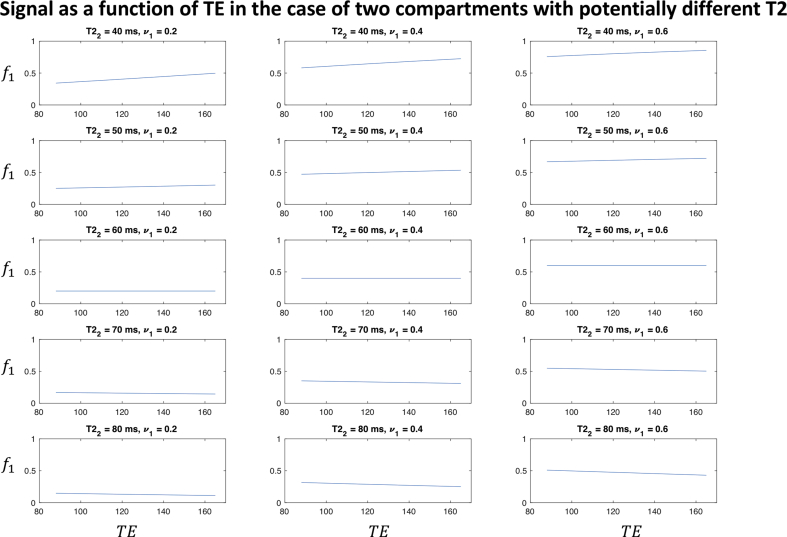
A two-compartment model STE,b=ν1exp−TE/T21exp−bD1+1−ν1exp−TE/T22exp−bD2 - in which the two compartments can have different T2 - represented by STE,b=STE,0(f1TEexp−bD1+1−f1exp−bD2). Rearranging the equations gives f1TE=ν1exp−TE/T21/ν1exp−TE/T21+1−ν1exp−TE/T22. This relationship is plotted for T21=60ms and different values of ν1 and T22. When T22>T21, a decrease in f1 with increasing TE can be observed.